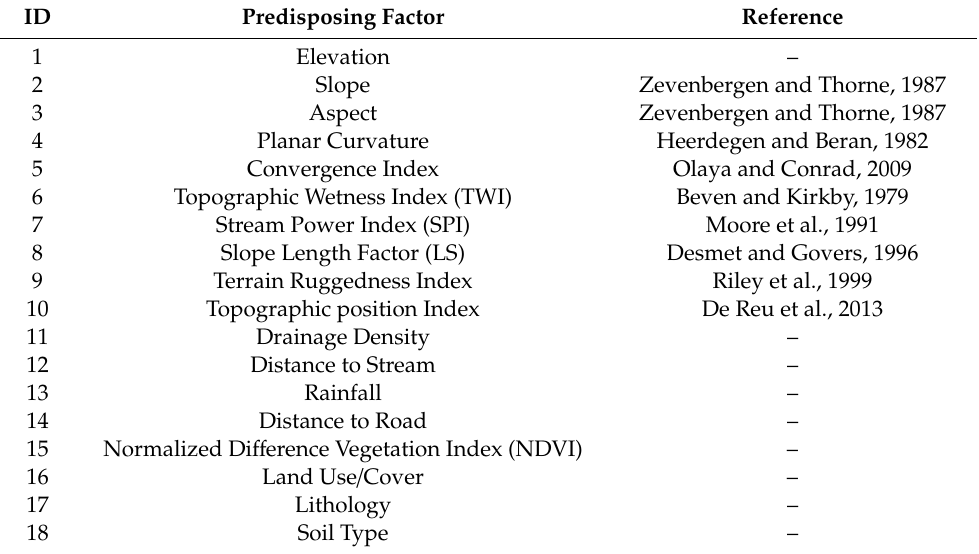
Table 1. List of Predisposing Factors and their Source.